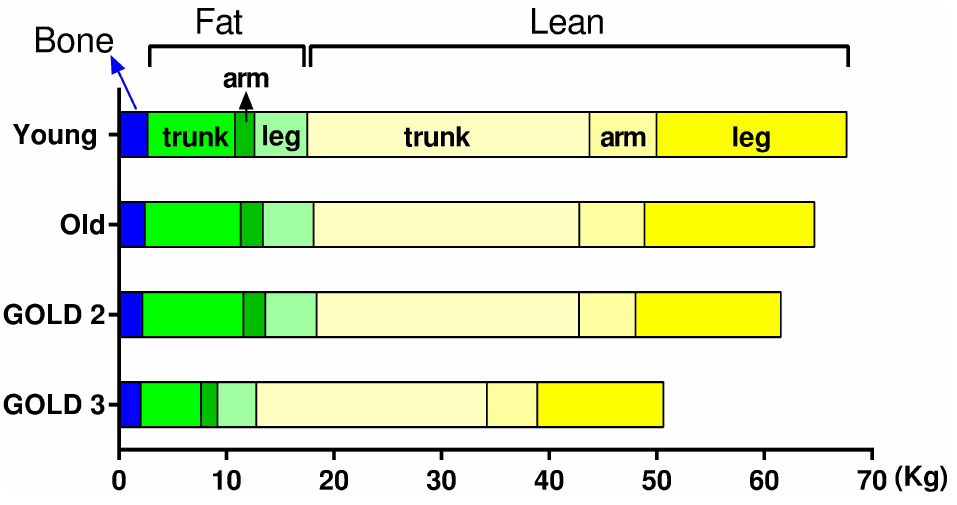
Fig 3. Summary of the dynamic changes in body composition among groups.